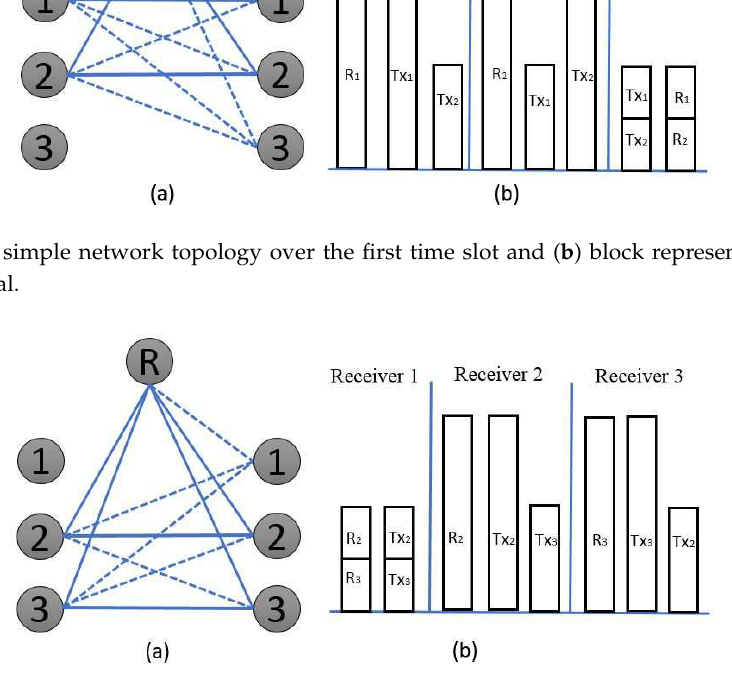
Figure 5. ( a ) simple network topology over the second time slot and ( b ) block representation of the received signal.